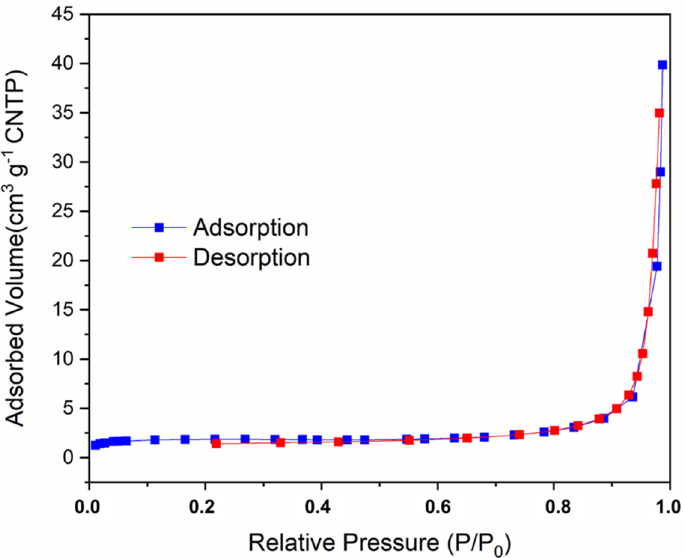
Figure 5. N 2 physisorption isotherms for the activated compound (sample RCA − 1).